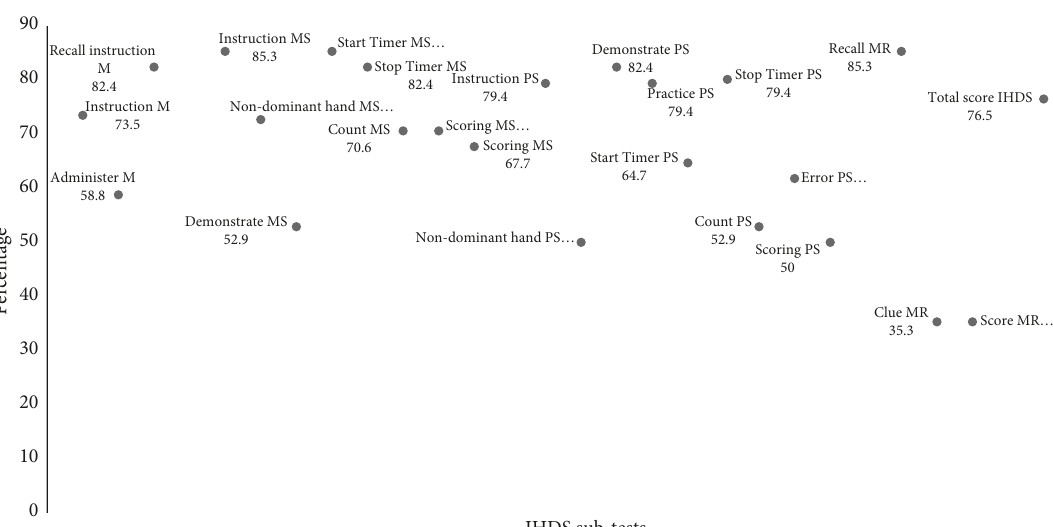
Figure 5: Healthcare workers’ performance of the International HIV Dementia Scale